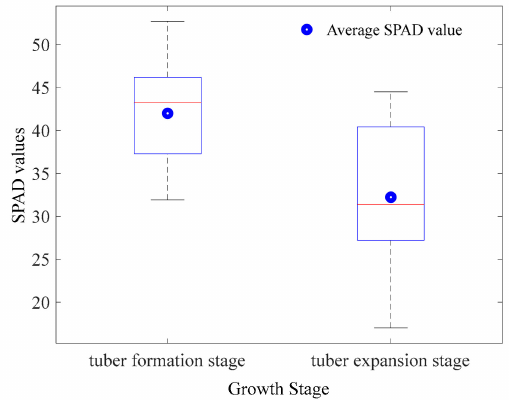
Figure 10. The boxplot of the SPAD value statistics of potato plants at two